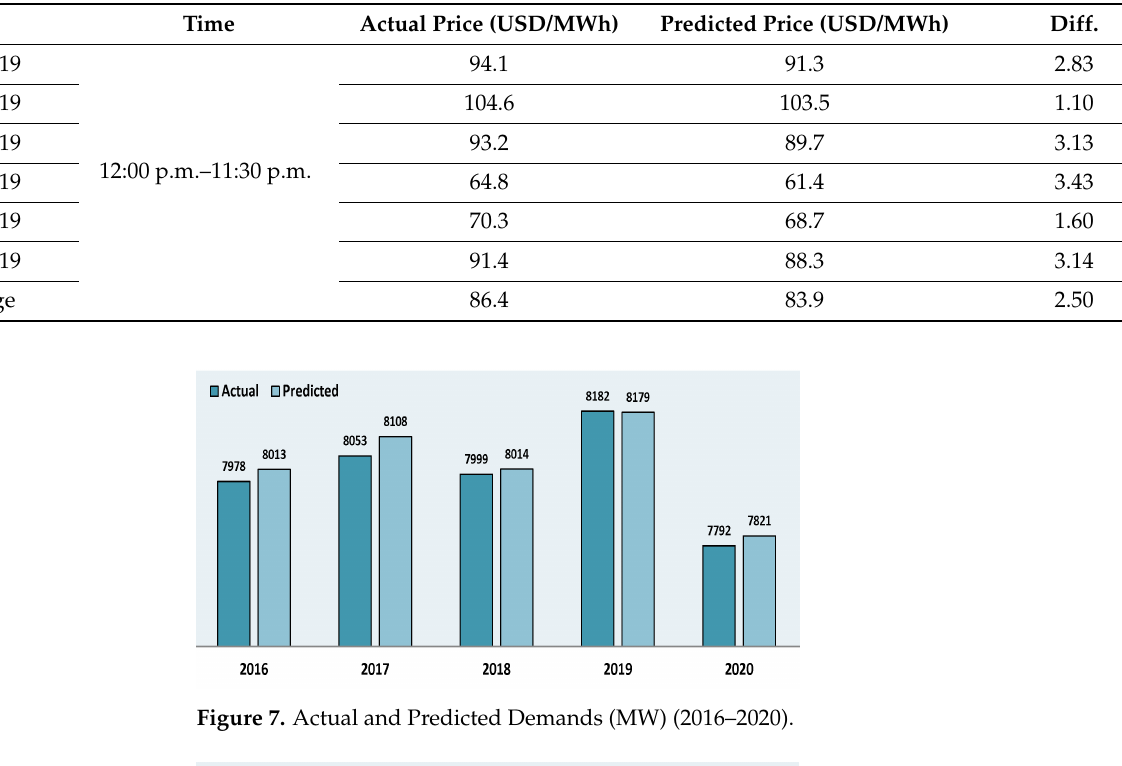
Table 2. Difference between actual and predicted Price for a period of six months.